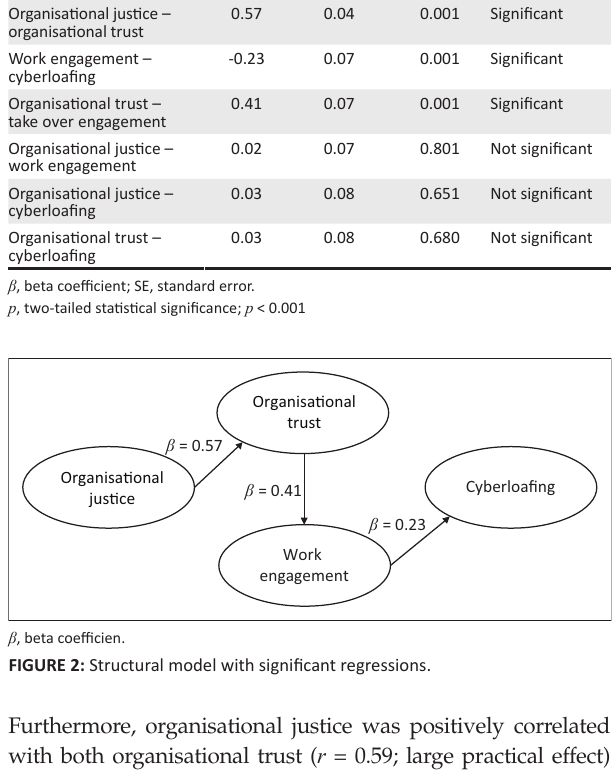
TABLE 4: Regression results for the structural model. Structural